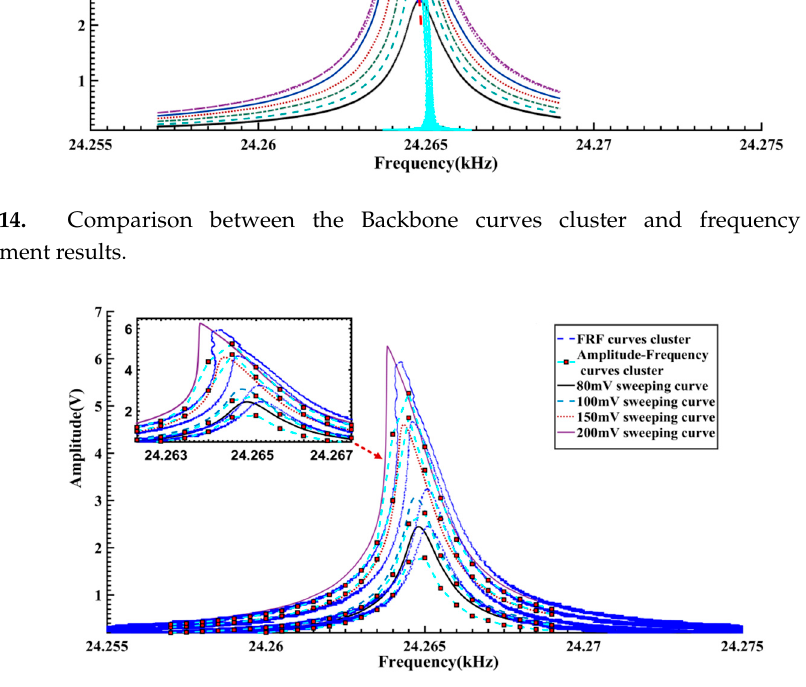
Figure 15 . Contrast between FRF curves cluster, Amplitude-frequency curves cluster and frequency sweeping results.